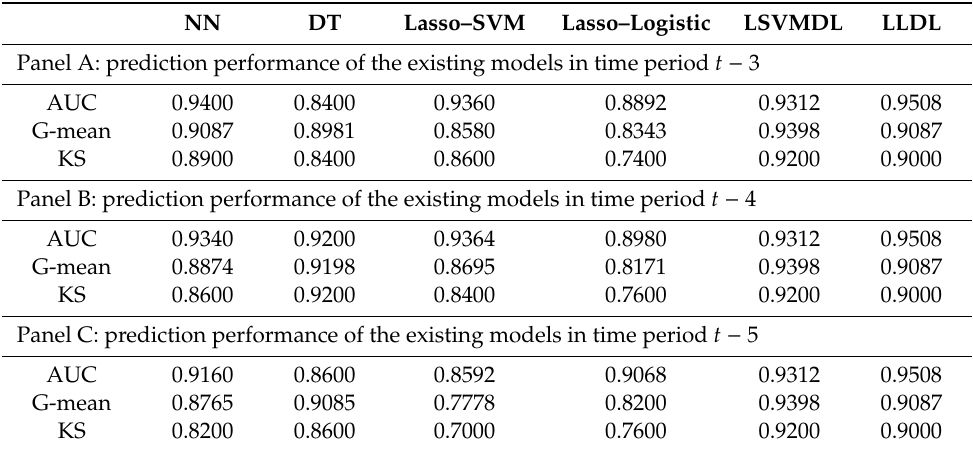
Table 6. Prediction results of NN, DT, lasso–SVM and lasso–logistic models in the single year time window versus the lasso–SVM-distributed lag (LSVMDL) model and the lasso–logistic-distributed lag (LLDL) model (financial ratios plus macroeconomic